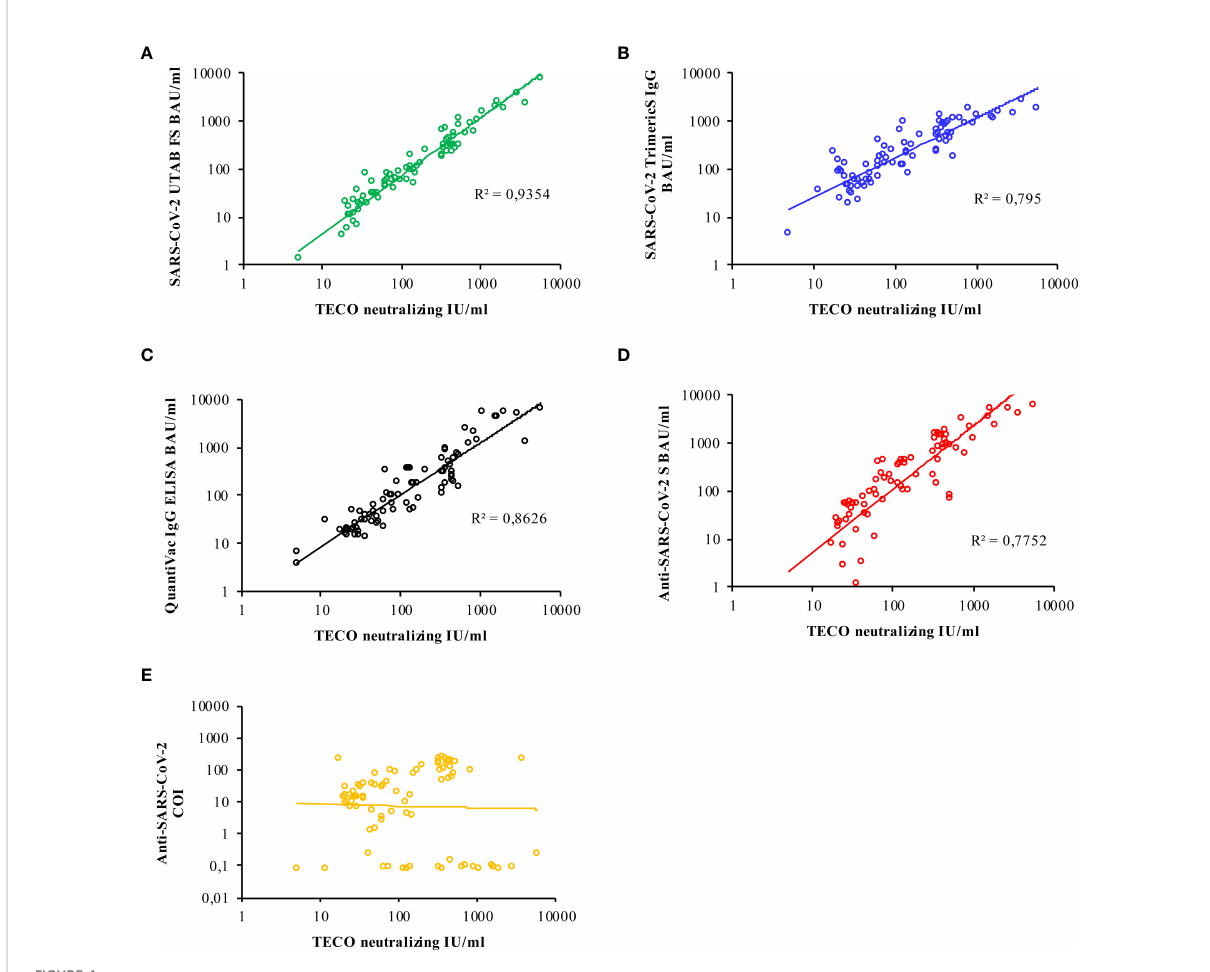
FIGURE 4 Logarithmic correlation for each immuno-assay (A – E) , compared to neutralizing antibody titer measured with the TECO-ELISA. Results for Roche N-Test (E) are only semi-quantitative and reported as cut-off-index (COI); due to observed kind of correlation of Roche N, no R2 is indicated. A total of 83 samples (COVID-19 patients and vaccinated individuals) was measured. Additional evaluation of corresponding correlations by Passing & Bablok / Spearman coef fi cient is given in Supplement Figure